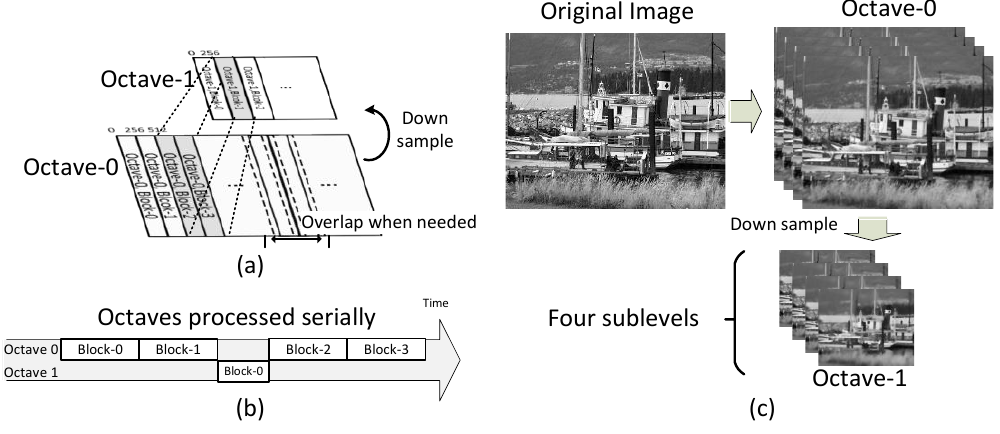
Figure 5. ( a ) Block-partitioning scheme in a nonlinear scale pyramid; ( b ) Specific order to process octaves in series, where different blocks in multi-octaves are divided and combined in a ribbon-like form to fit the octave-serial system architecture; ( c ) An example of a two-octave